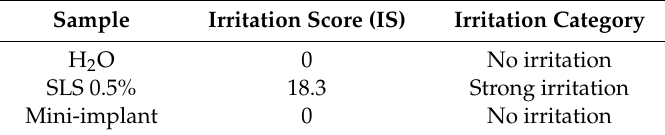
Table 3. Classification of the mini-implant alloy irritation potential .